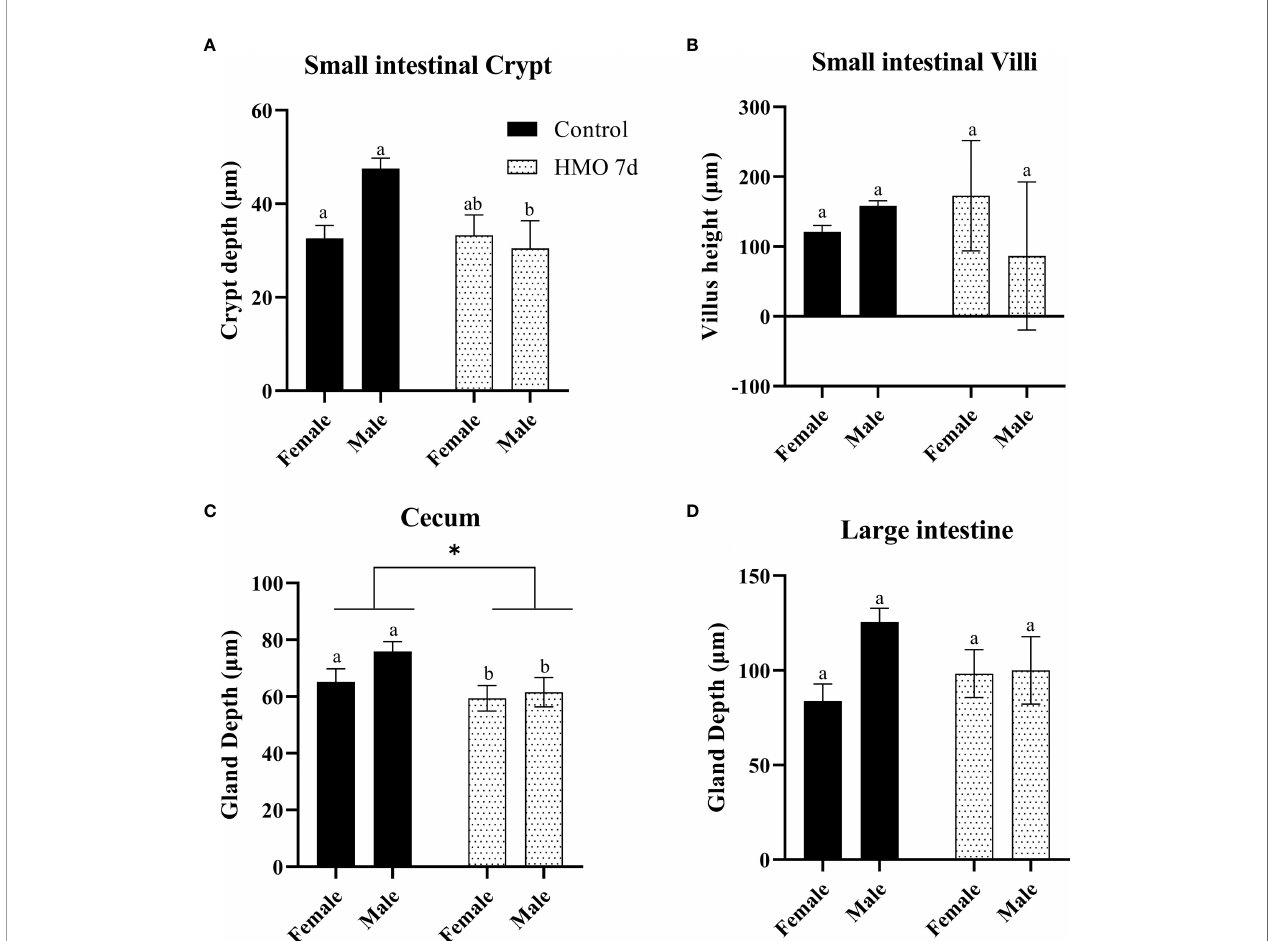
FIGURE 1 | Histomorphometric parameters analyzed in the control groups (n=18; M = 11, F = 7) and in the mice that received human milk oligosaccharides (HMOs) for 7 days and euthanized at 28 days of age (n=7; M = 3, F = 4). (A) Small intestinal (SI) crypt depth (µm). (B) SI villus height (µm). (C) Cecal gland depth (µm). (D) Large intestinal gland depth (µm). a,b Different superscripts represent the statistical difference between individual groups. *Represents the statistical difference between groups regardless of sex.